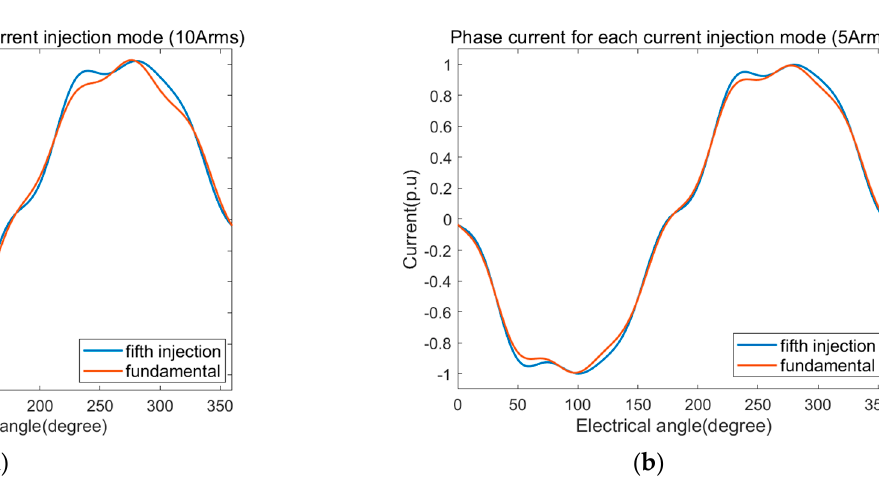
Figure 16. A comparison of current waveforms optimized for the actual fundamental-controlled operation ( a ) at 10 Arms and ( b ) 5